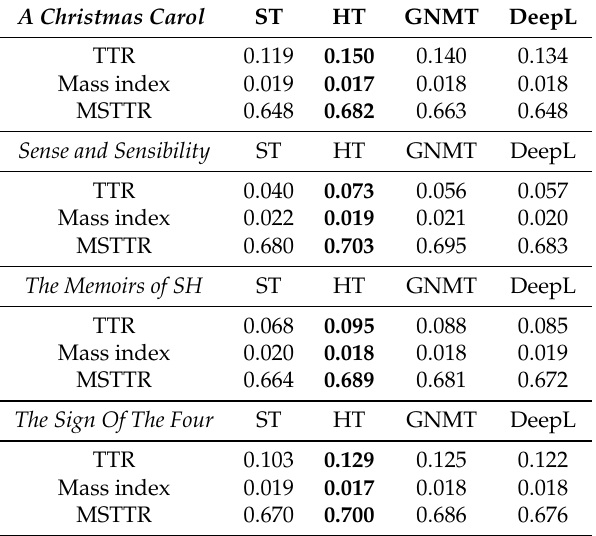
Table 6. Overview TTR-values per novel for ST, HT, GNMT, and